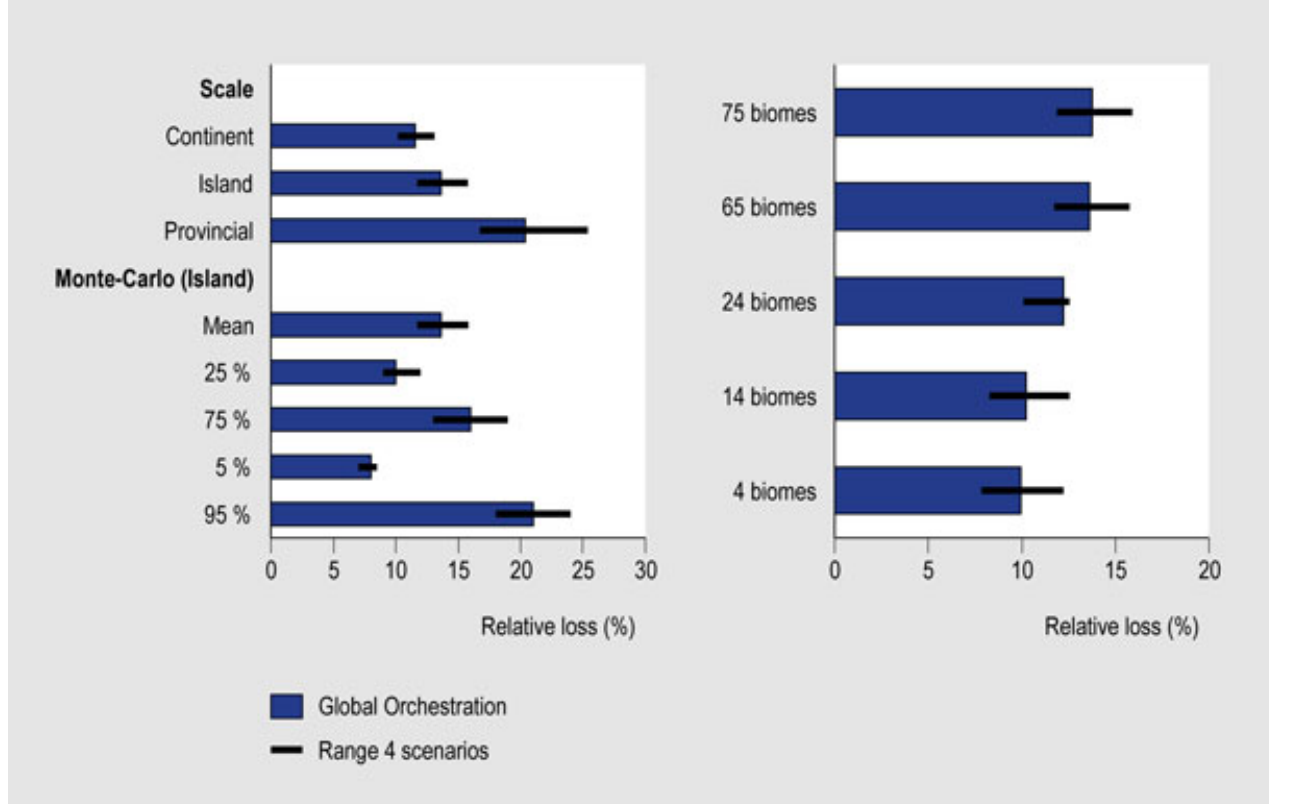
Fig. 5. Uncertainty analysis on the relative global losses of vascular plant species at equilibrium. Figure shows the uncertainty to a) the value of z as function of scale and the uncertainty in Island scale z -values (Monte Carlo analysis; 25–75% and 5–95% range are shown) and b) the effect of modifying the number of units distinguished in the analysis. This analysis is based on the Global Orchestration scenario. The uncertainty bars indicate the maximum and minimum values in the total set of